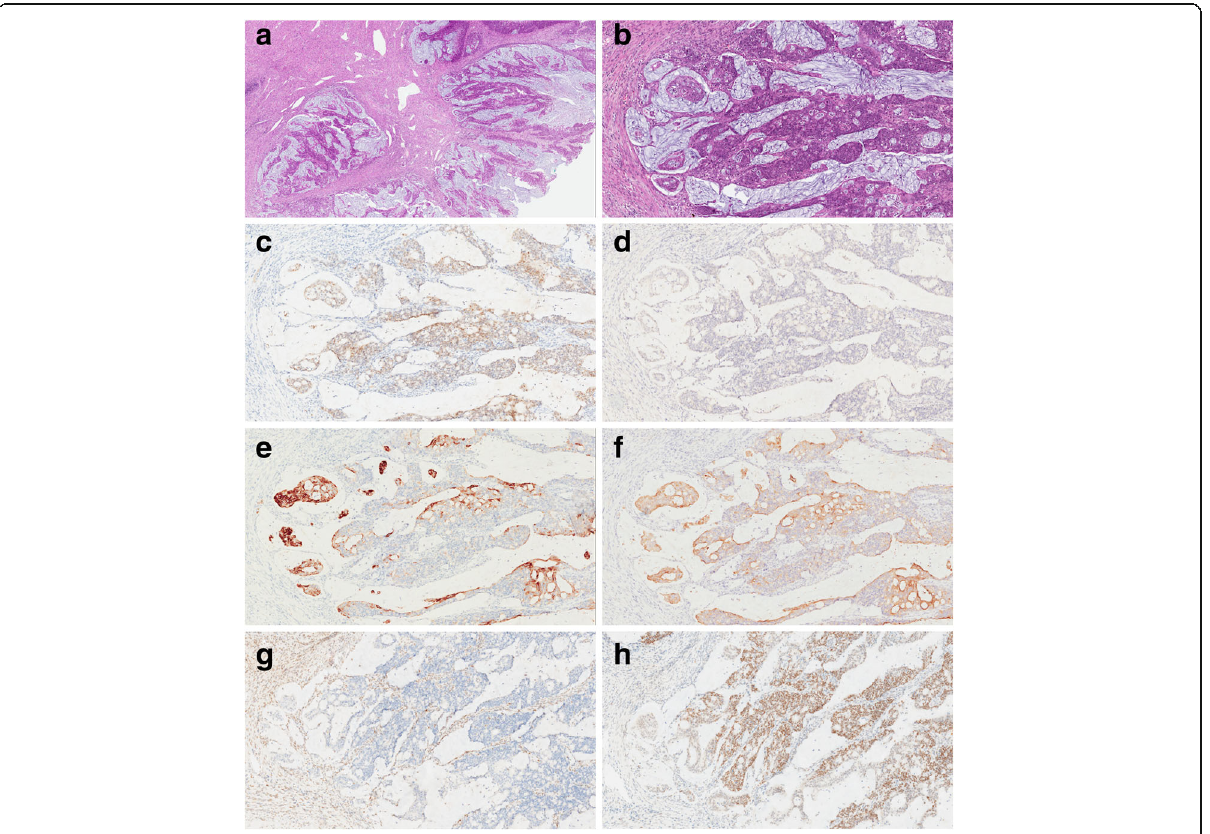
Fig. 2 Microscopic findings: H&E sections at low (40×, a ) and high (200×, b ) magnification showed mucinous differentiation with major elements of solid and cribriform growth patterns. The immunohistochemical phenotype was characterised by positivity for CDX2 ( c ), and negativity for PAX8 ( d ). Correspondingly, the expression of CK20 ( e ) followed the CDX2 postive areas. However, CK7 ( f ) was also present. MLH1 staining ( g ) showed a protein loss, whereas MSH2 remained positive ( h ). Of note, stromal cells served as positive internal controls for MLH1 and MSH2 ( g , h